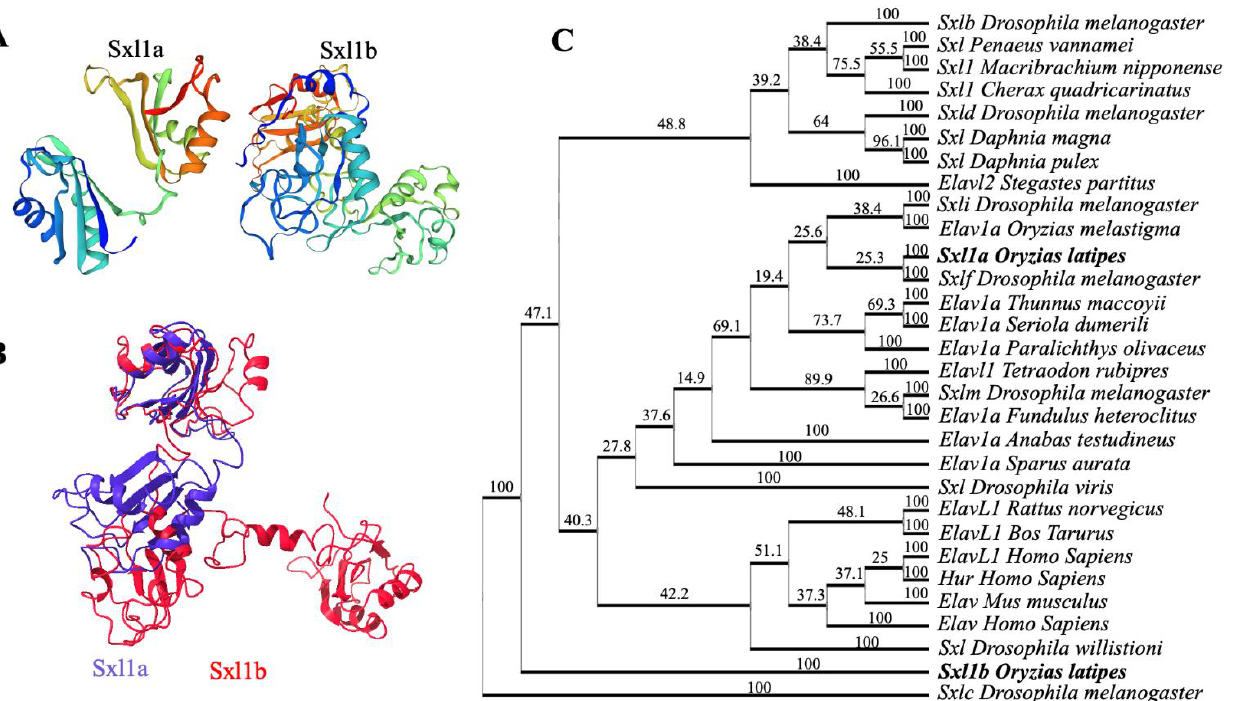
Figure 1. Putative protein structure and phylogenetic analysis of two Sxl1 isoforms in medaka. Three-dimensional modeling was performed to visualize the monomeric structure of Sxl1a and Sxl1b ( A ) proteins, and both structures were superimposed using Chimera-X 1.5 software to depict the similarities between medaka Sxl1 homologues ( B ). Phylogenetic analysis ( C ) was carried out using ClustalW. The tree was generated with PHYLIP and viewed with the Phylodendron online software. Values on the tree represent bootstrap scores of 1000 trails. Drosophila melanogaster Sxlc was used as an out-group.